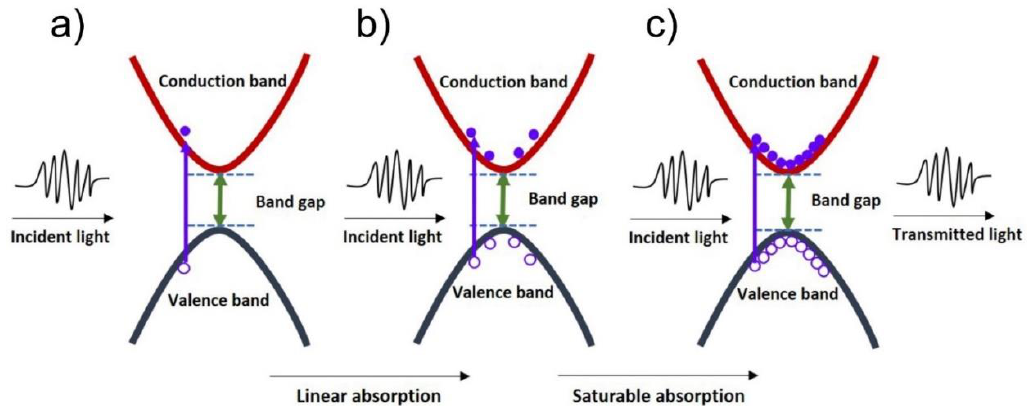
Figure 11. The process of linear absorption and saturable absorption of 2D materials due to Pauli Blocking effect. ( a ) Electrons from the valence band absorb the incident light and are excited to the conduction band. ( b ) More electrons are excited, later they got thermalized and cooled down by the intraband scattering effect. ( c ) When the incident light is sufficiently high, the conduction band is saturated, and the vast majority of light is transmitted rather than absorbed due to the Pauli blocking effect.